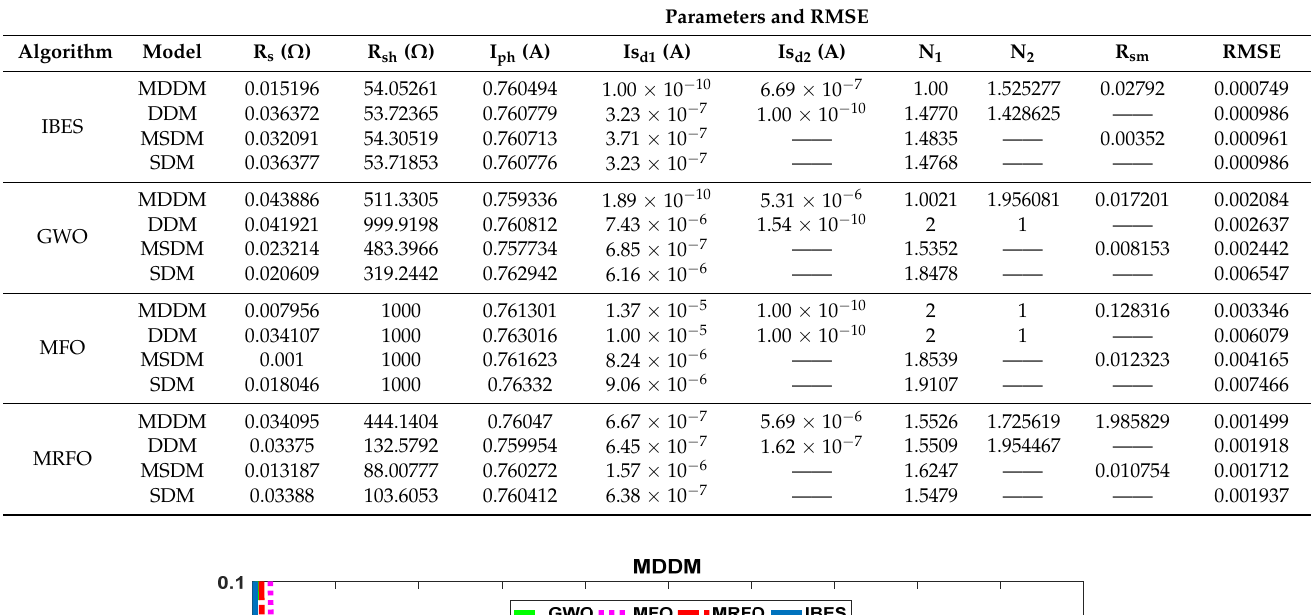
Figure 20. Comparison between the RMSE values of the IBES, GWO, MFO, and MRFO applied to the MDDM, DDM, MSDM, and SDM.